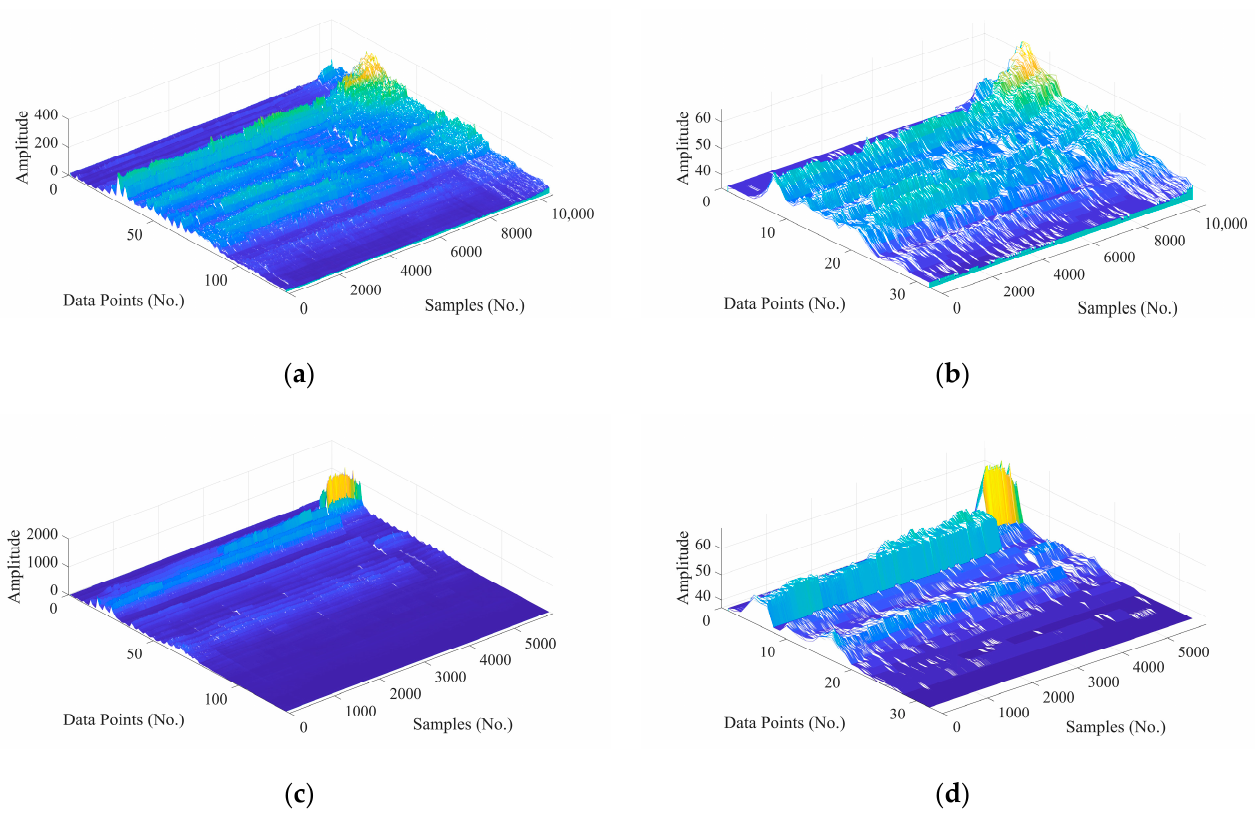
Figure 13. Fault type in Dataset 1: ( a ) outer race fault, ( b ) inner race fault, ( c ) ball fault; fault type in Dataset 2: ( d ) gear pitting